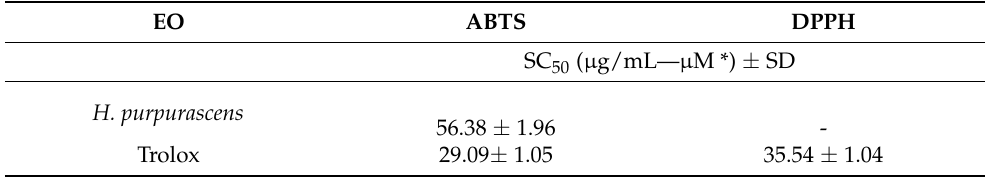
Table 4. Half scavenging capacity of H. purpurascens